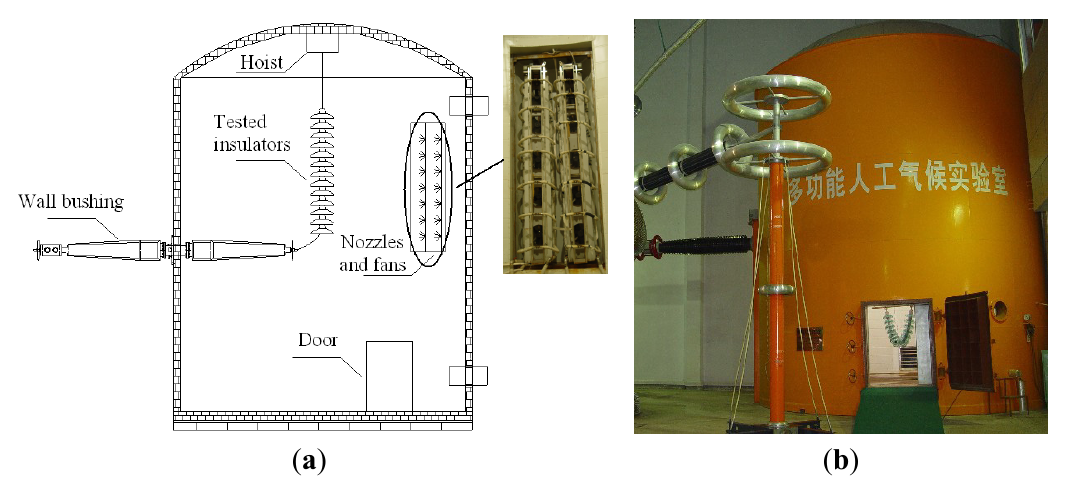
Figure 1. The artificial climate chamber in Chongqing University. ( a ) Schematic of the artificial climate chamber; ( b ) Photograph of the artificial climate